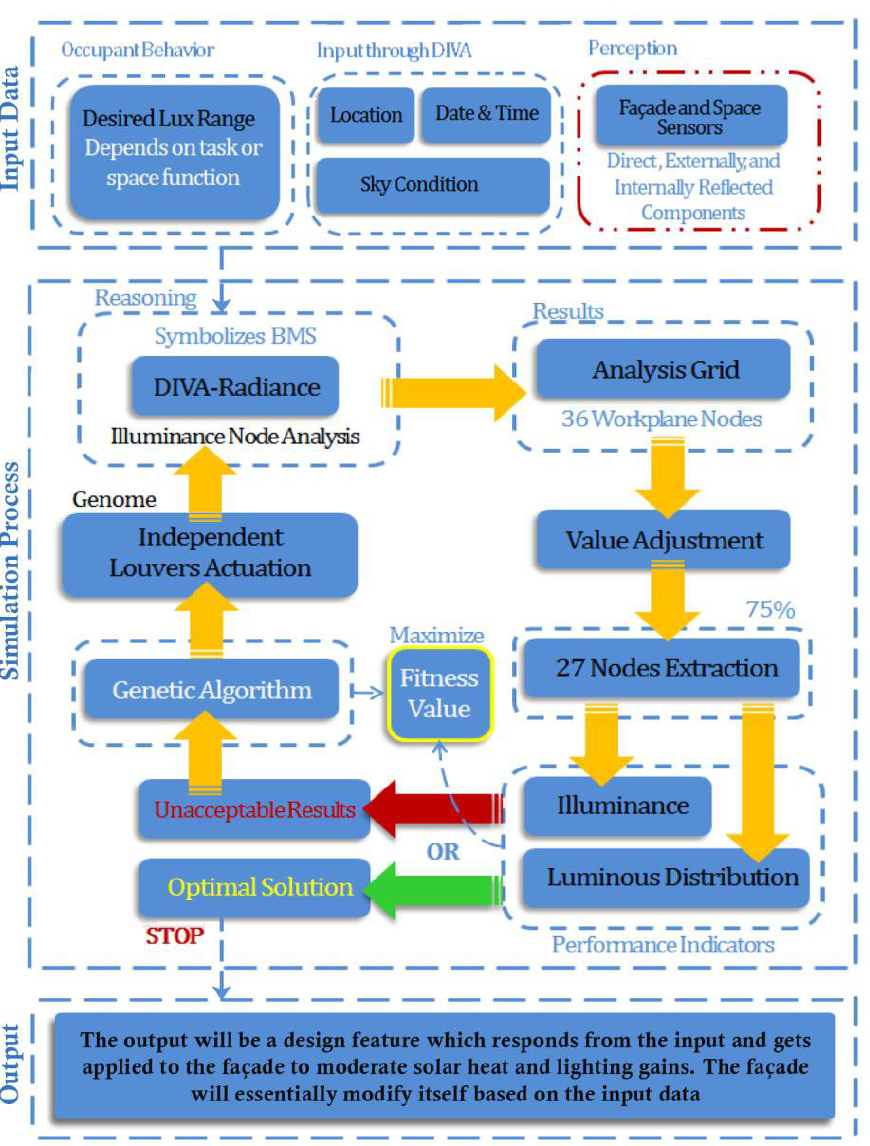
Figure 6. System logic – the path of data exchange between the proposed algorithm and the daylighting simulation tool. (El-Sheikh,